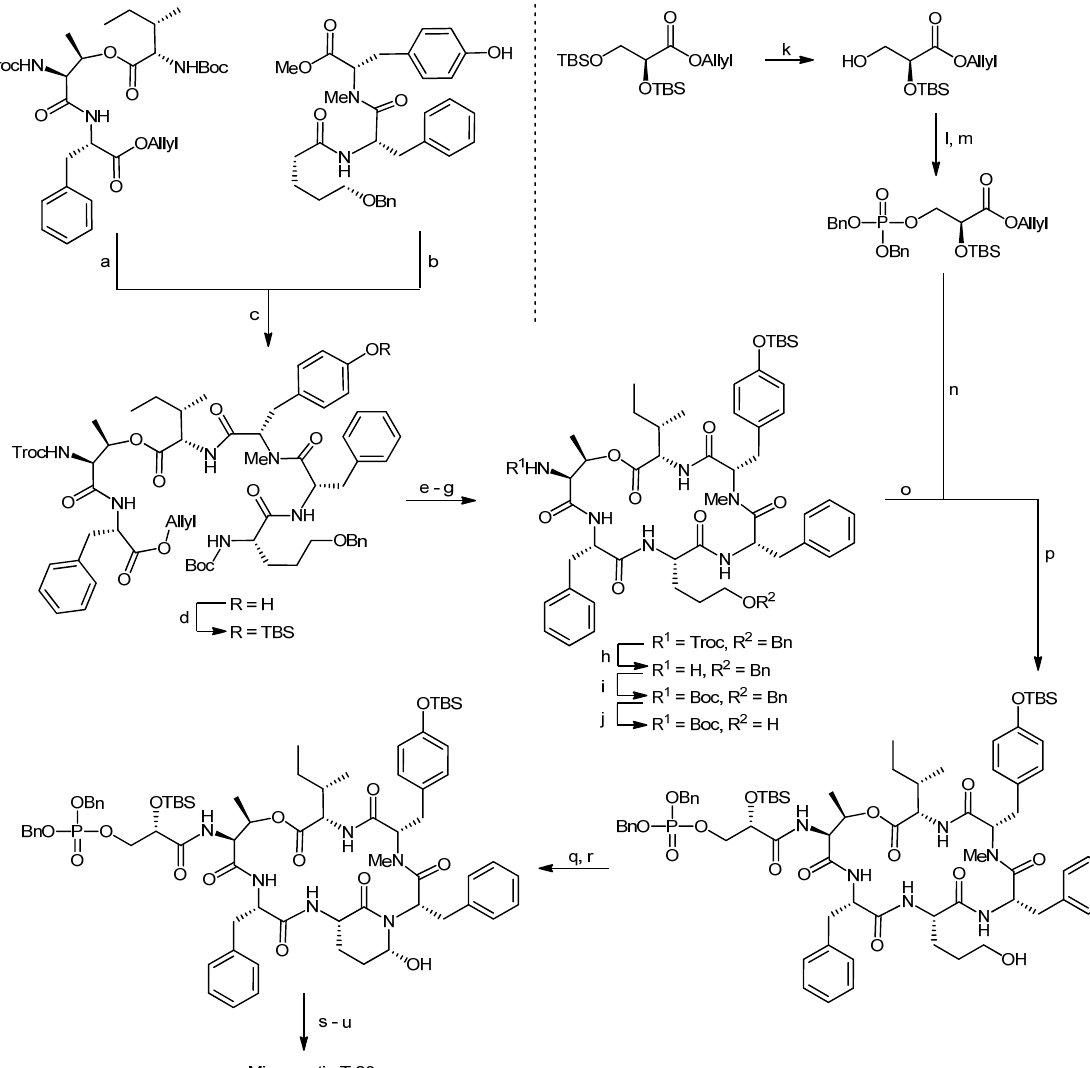
Scheme 19. Assembly of the micropeptin T-20 framework and construction of the Ahp moiety